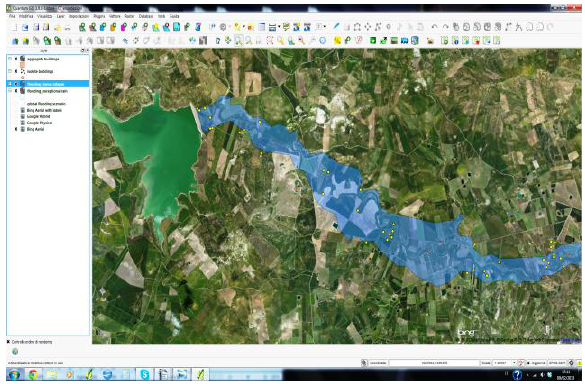
Figure 7. Potential risk for isolated buildings related to the predictable flooding scenario.